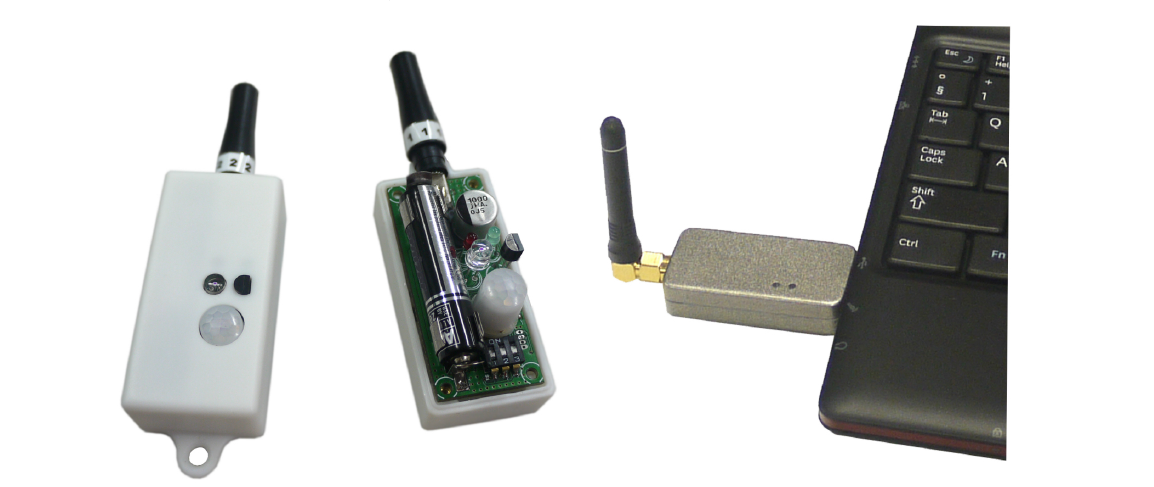
Figure 1. Wireless sensor box with housing (left) and an inside view of the same sensor box (middle) displaying PCB board with environmental sensors and primary cell; receiver unit with antenna (right) is connected to the central computer unit serving as a data server and Web link (between the two devices a bidirectional data transmission is established).